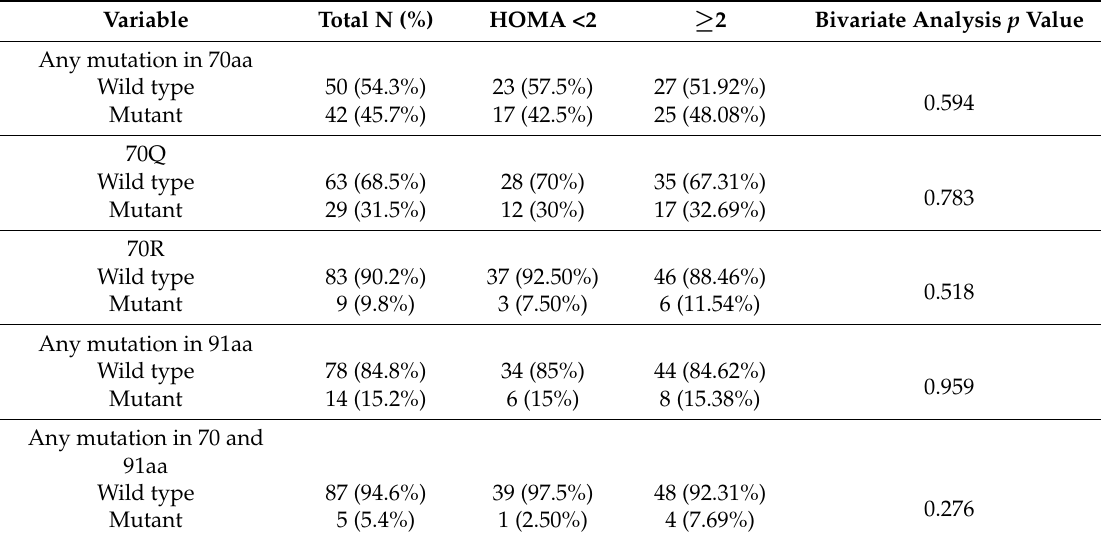
Table 3. Evaluation of insulin resistance defined by HOMA index according genetic variability of HCV core gene (aa 70 and 91) in 92 patients with